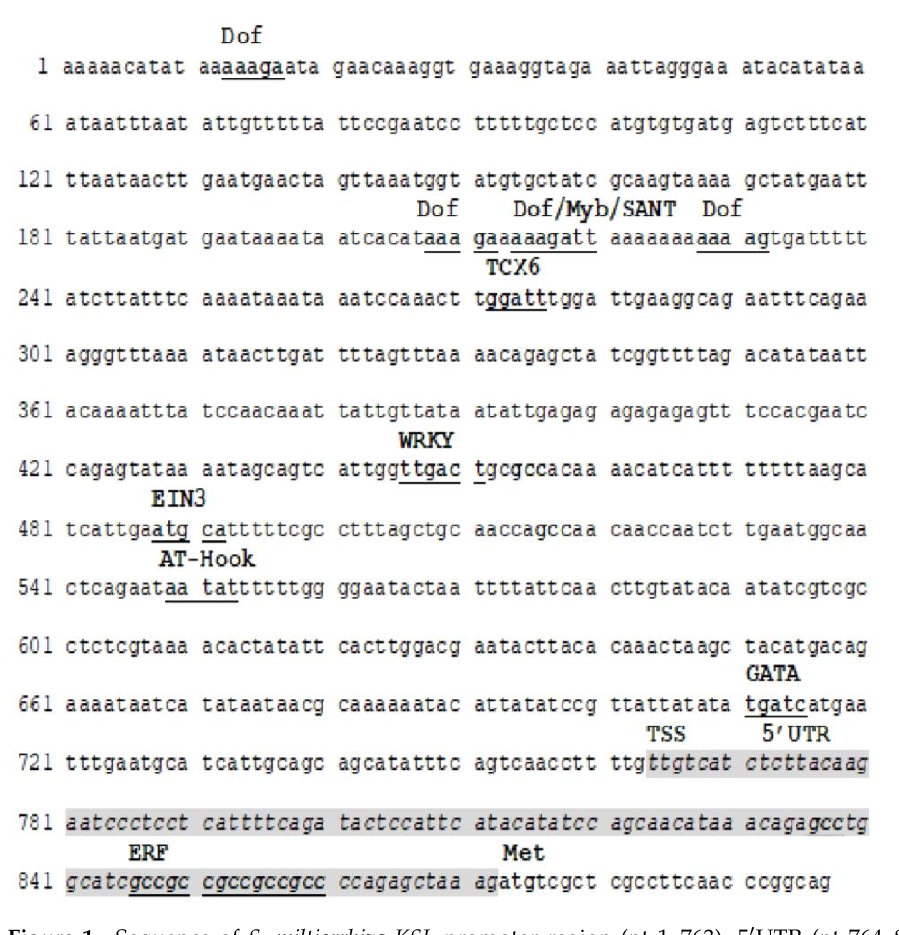
Figure 1. Sequence of S. miltiorrhiza KSL promoter region (nt 1 –763), 5′UTR (nt 764–872), and 5′ frag- 5 (cid:48) fragment of KSL cDNA (nt 873–897). Only strand + is provided. Positions of cis -active elementswere ment of KSL cDNA (nt 873 – 897). Only strand + is provided. Positions of cis -active elementswere underlined. SmKSL gene 5 (cid:48) UTR is shaded and written underlined. SmKSL gene 5′UTR is shaded and written initalics.